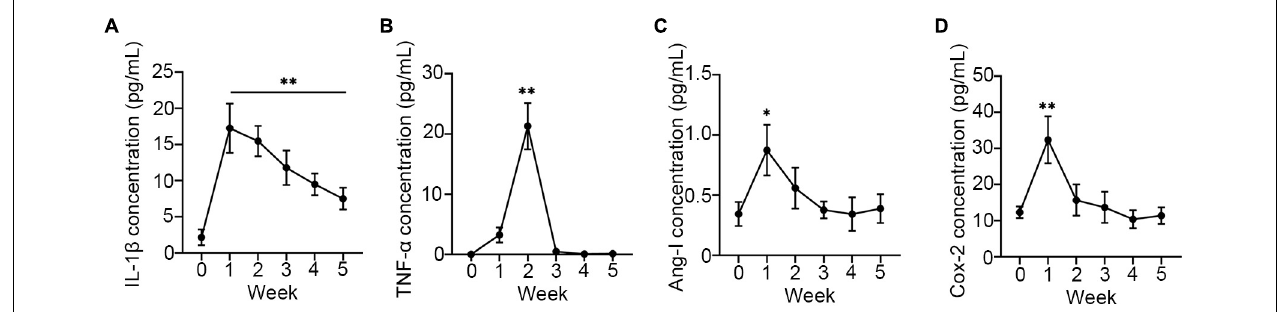
FIGURE 1 | Proinflammatory was upregulated in sputum of neonates. The concentration of IL-1 β (A) , TNF- α (B) , Ang-1 (C) , and COX-2 (D) were assay using ELISA in sputum of neonates every week after receiving oxygen therapy. One-way ANOVA, ∗ p < 0.05, ∗∗ p < 0.01 vs. 0 week, n = 37.